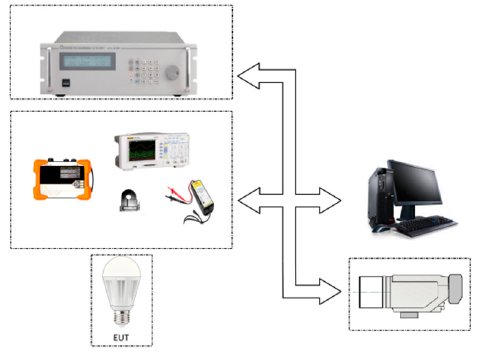
Figure 1. Diagram of the applied measurement setup.